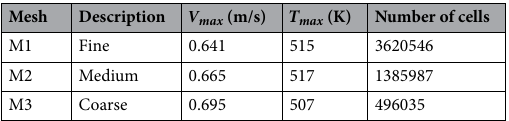
Table 1. Comparative results of tested computational grids.